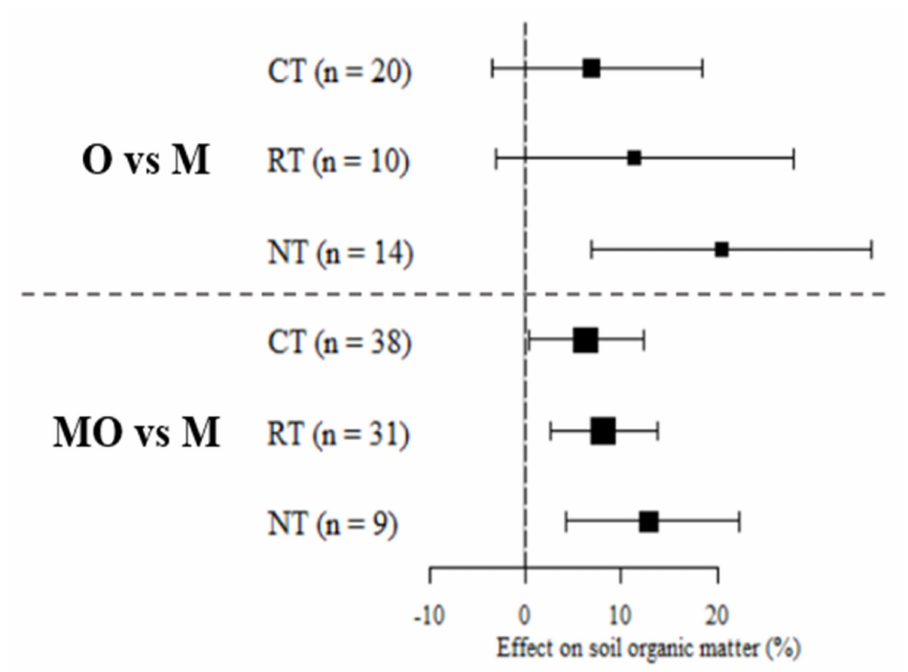
Figure 3. The soil organic matter (SOM) response of organic vs. mineral (O vs. M), and mineral + organic vs. mineral (MO vs. M) under conventional, reduced, and no-tillage practices (CT, RT, and NT, respectively), expressed as the average effect on soil organic carbon (%). “n” refers to the number of observations for each subgroup. The vertical line represents the null hypothesis [ ln ( RR ) = 0]. The squares are the point estimate of effect size. The horizontal lines are the associated 95% confidence interval for the population